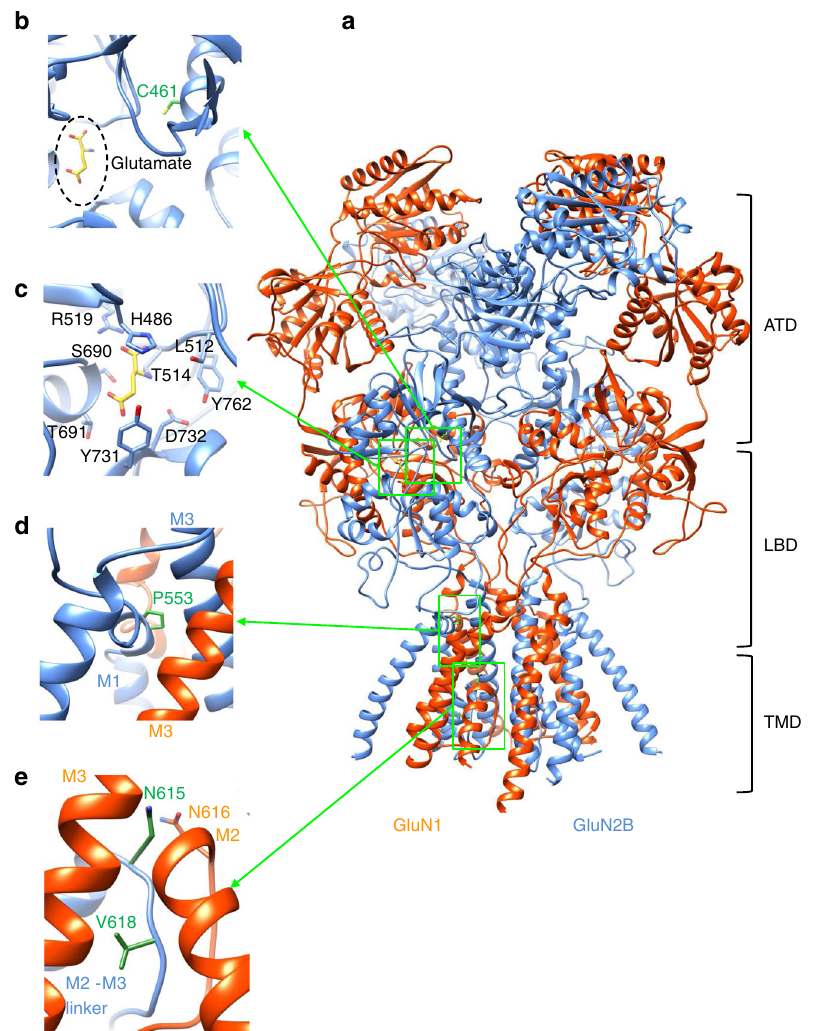
Fig. 1 Location of missense mutations in the GluN2B subunit. a Homology hybrid model of the human tetrameric GluN1 – GluN2B receptor using the rat (PDB: 4PE5) and frog (PDB: 4TLL, 4TLM) crystal structures as templates (orange: GluN1, blue: GluN2B). The amino terminal domain (ATD), ligand binding domain (LBD) and transmembrane domain (TMD) of the subunits are shown in ribbon format with the residues selected for study in green in stick format. b C461 is located in the S1 region of the LBD, proximal to the glutamate binding site with bound glutamate (yellow). c Glutamate at the orthosteric binding site (position taken from rat NMDAR structure; PDB: 4PE5). d P553 is located in pre-M1 in close proximity to M3. e N615 is located at the beginning of